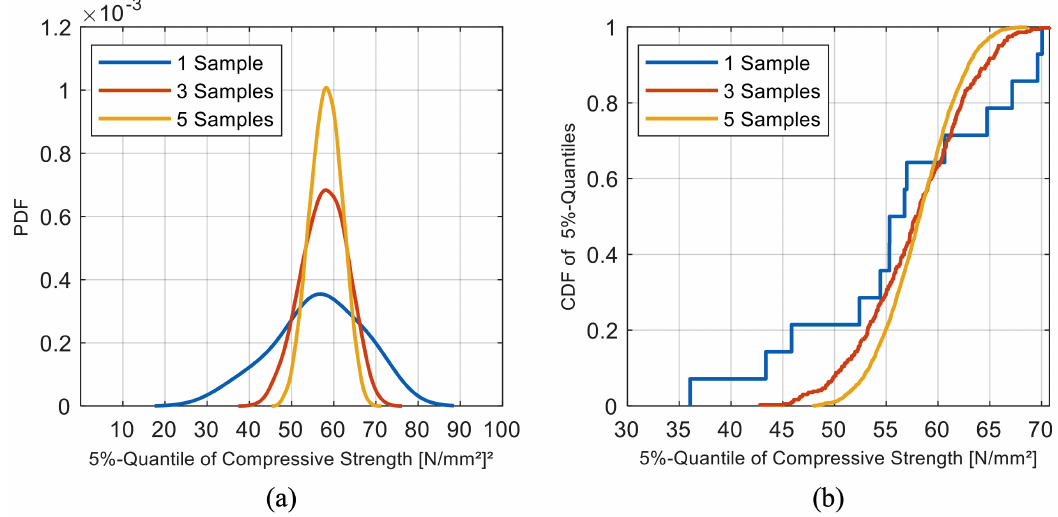
Figure 8. (a) kernel density function and (b) eCDF of the simulation results of 5 %-quantiles using 1, 3 and 5 drill